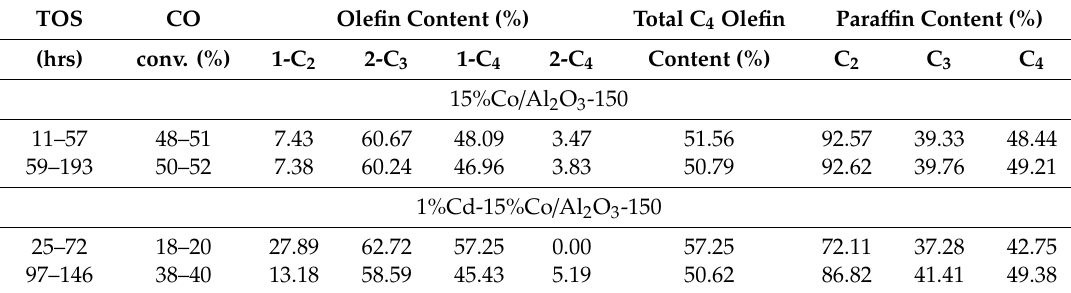
Table 3. Olefins and para ffi ns contents of unpromoted and Cd, In, Sn and Pt promoted 15%Co / Al 2 O 3 catalysts (a)